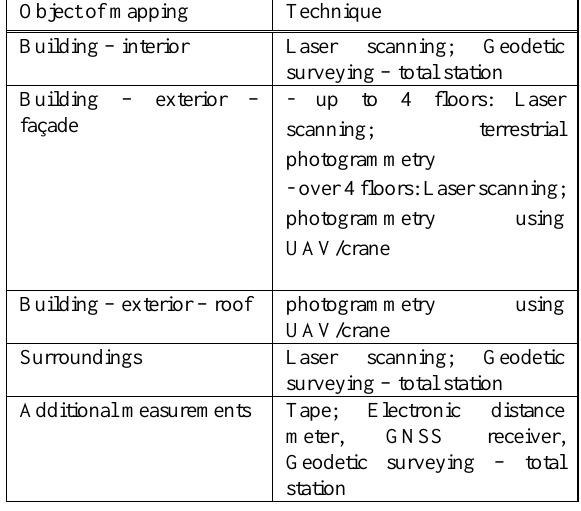
Table 3. Technique